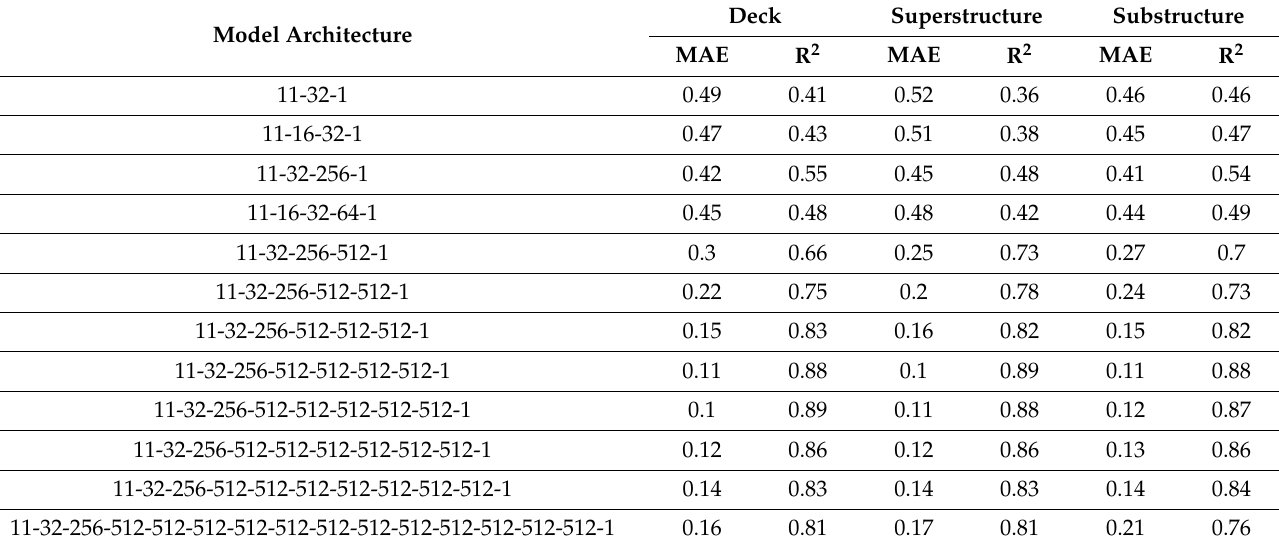
Table 5. Validation of the numerous network